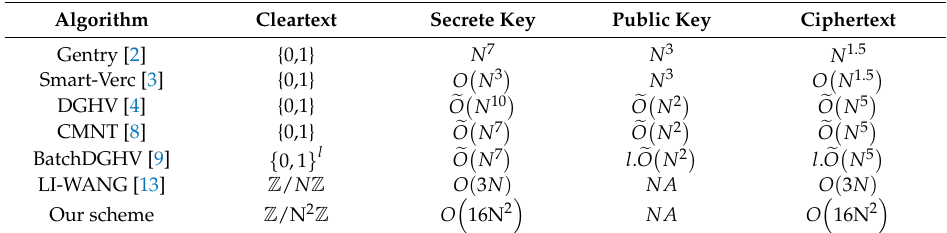
Table 1. Comparison of the performances of VFHE scheme (N is a security